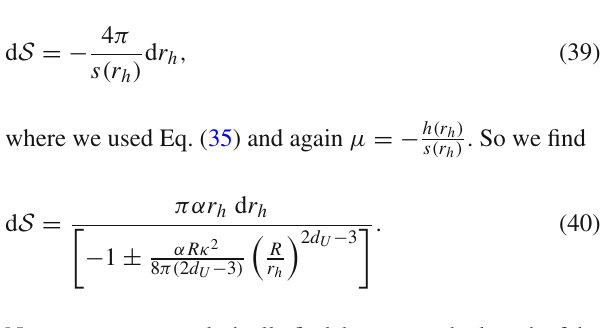
Fig. 3 Hawking temperature as a function of r for the scalar unparticle case for three values of d U . We have considered (cid:2) U = 1, α = 0 . 5, μ = 0 . 7, κ = 1, and κ ∗ = 10